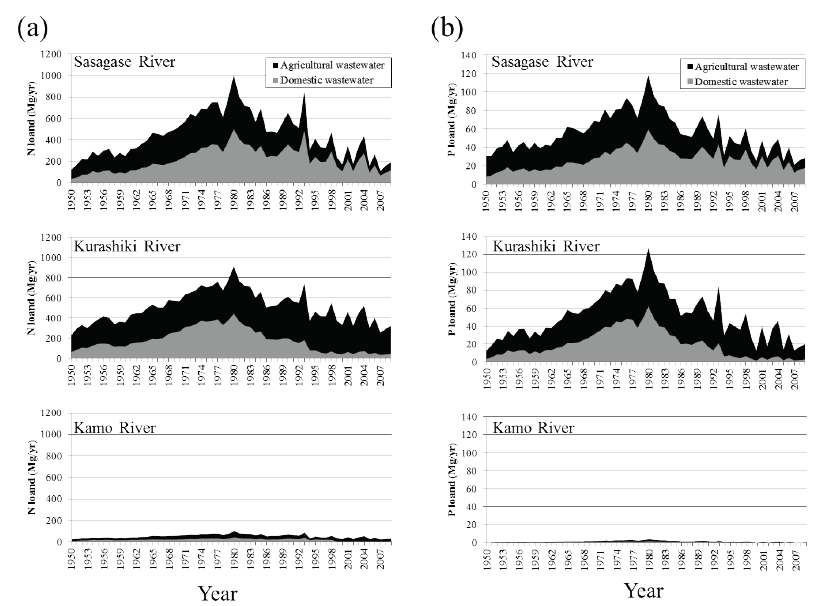
Fig. 4 Estimated nutrient loads from the rivers to the lake, (a) T-N and (b)